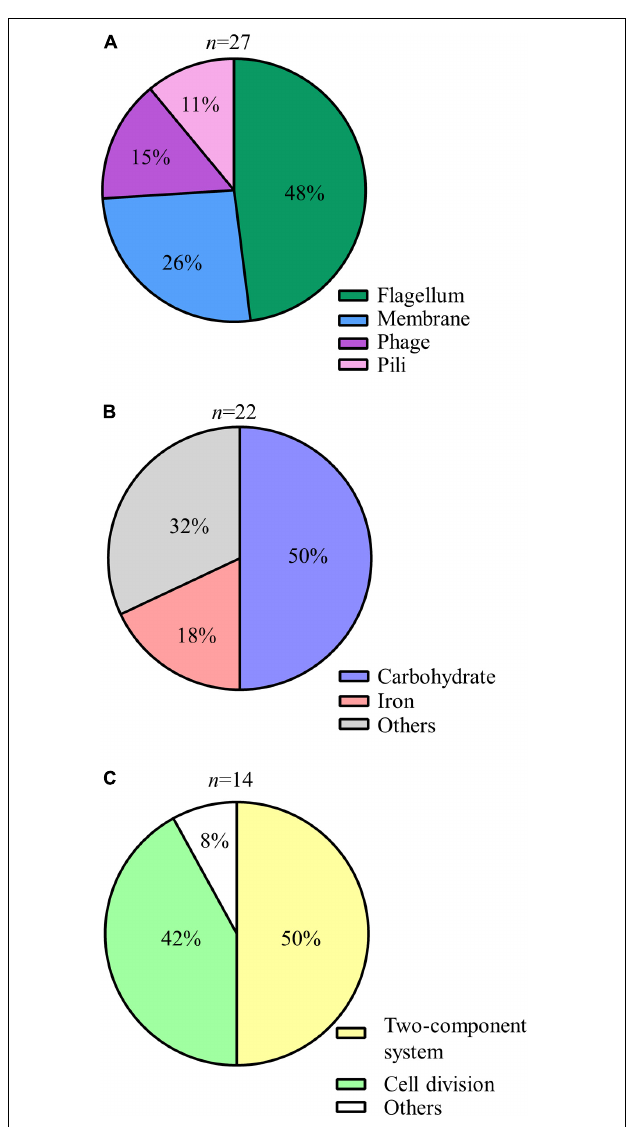
FIGURE 3 | Detailed classification of the identified genes (A–C) Pie charts showing details of the predicted functions of encoded proteins of the genes detected by STM: cellar component (A) , metabolism (B) , and regulation (C) .